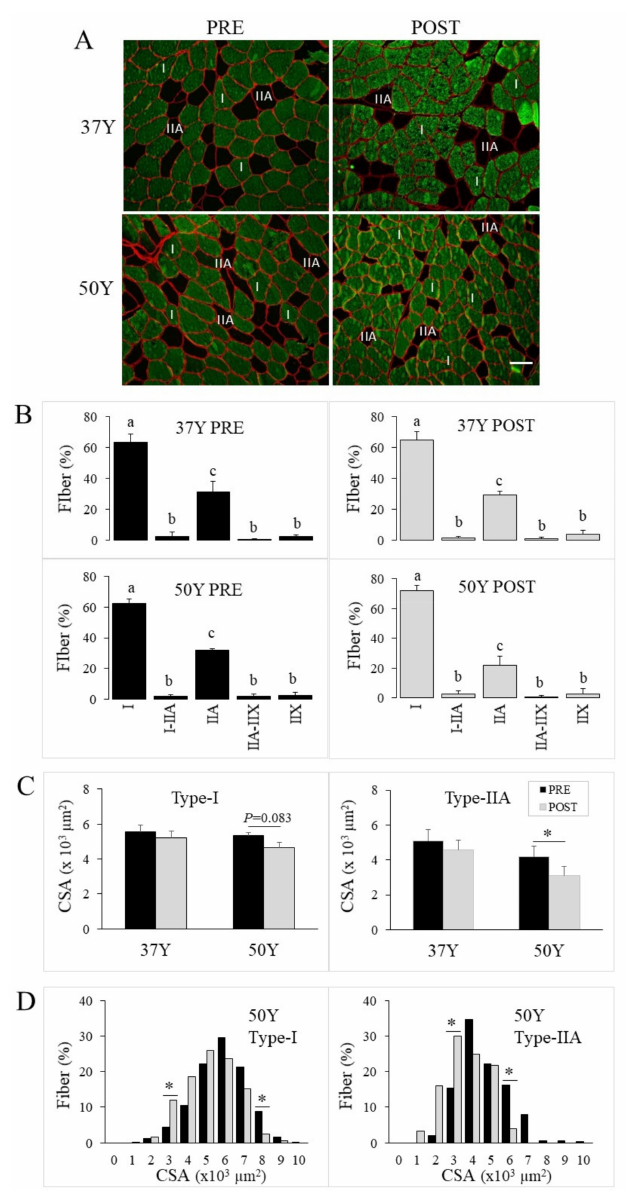
Figure 1. Fiber type-specific distribution and morphometry. Vastus lateralis biopsies were from 37Y and 50Y runners before (PRE) and after (POST) 24TR. ( A ) Representative images of cross-sections labeled for myosin heavy chain I (green) and counter-stained for laminin- α 1 (red) to outline the fibers; the scale bar represents 50 µ m. ( B ) The fiber type proportion was measured PRE (black bars) and POST (gray bars) 24TR for middle-aged (37Y) and master (50Y) runners. Different letters indicate a significant difference ( p < 0.05) between fiber types. ( C ) Mean cross-section area (CSA) of type-I (left) and type-IIA (right) fibers for 37Y and 50Y runners PRE- and POST-24TR; statistical interaction was p = 0.049 between time and group for type-IIA CSA. ( D ) Frequency histogram of CSA for type-I (left) and type-IIA (right) fibers PRE- and POST-24TR for 50Y runners. * p < 0.05 between PRE and